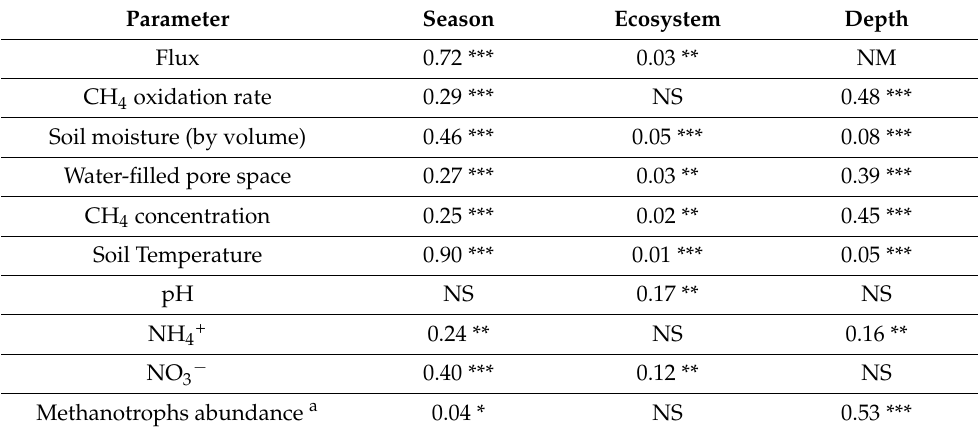
Figure 2. Methane flux variability on seasonal and local spatial (ecosystem) scales. Whiskers denote the 1st ( lower ) and the 3rd ( upper ) quartile. Significant differences between the groups ( p < 0.05) are indicated by letters. Table 2. Variance (omega-squared) in methane flux, soil oxidation rate and their environmental controls explained by season, ecosystem and depth in 3-way ANOVA and significance of differences found. Parameter